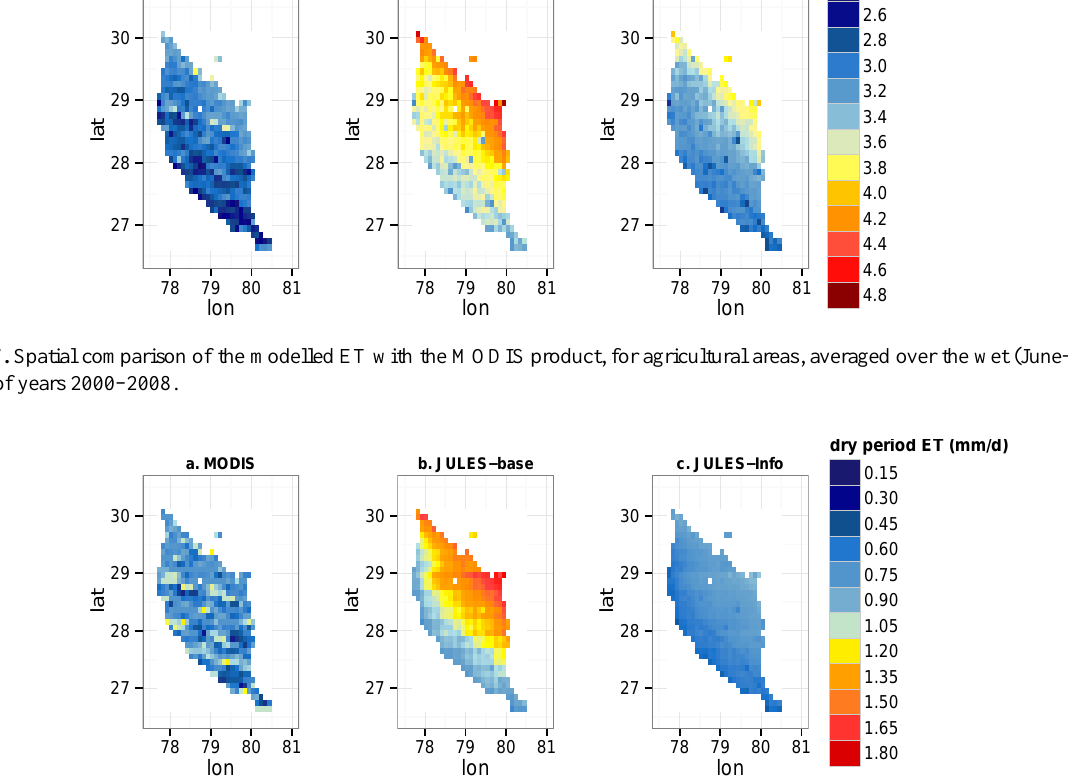
Figure 8. Spatial comparison of the modelled ET with the MODIS product, for agricultural areas, averaged over the dry (October–May) months of years